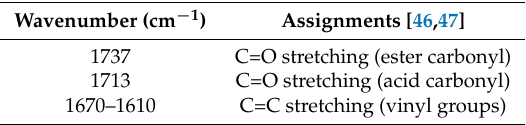
Table 3. Assignment of IR spectra absorption